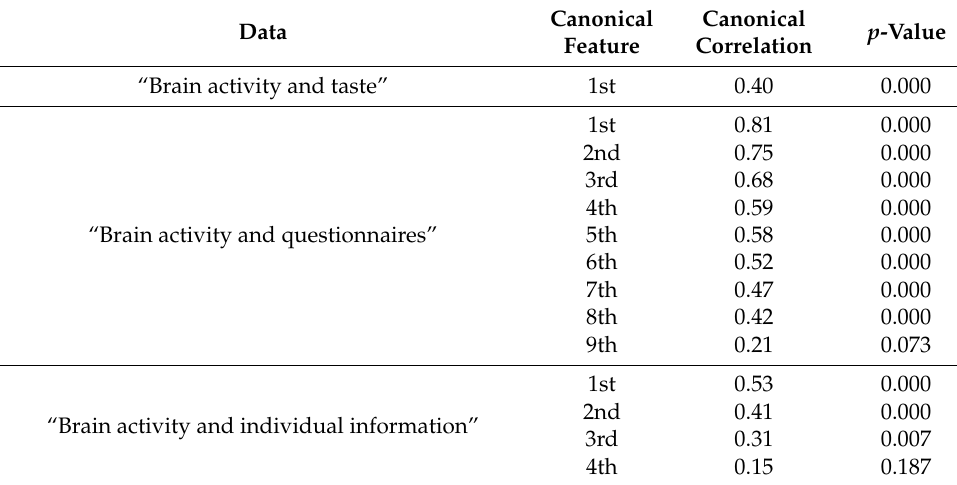
Table 5. Canonical correlation between heterogeneous